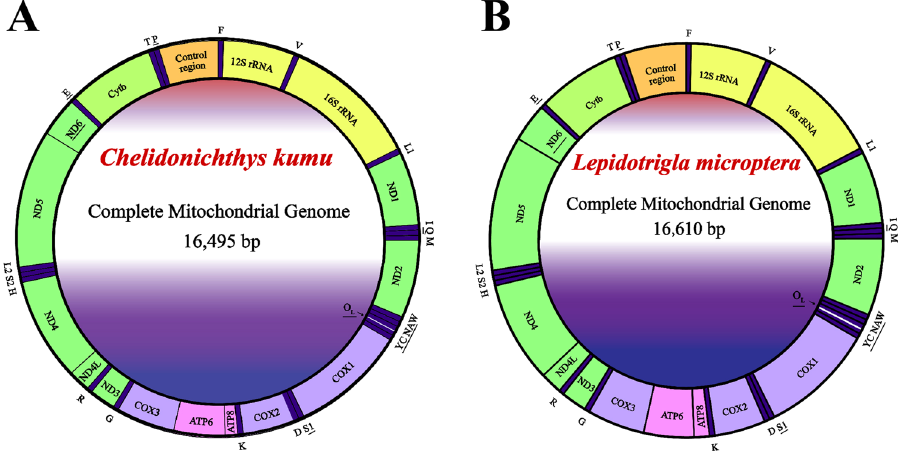
Figure 1. Circular map of the mitogenome of C. kumu ( A ) and L. microptera ( B ). Transfer RNAs are designated by the IUPAC-IUB single letter amino acid codes (L1: trnL CUN ; L2: trnL UUR ; S1: trnL AGN ; S2: trnL UCN ) Genome organization names not underlined indicate coding sequence on the heavy strand and those with underline indicate coding sequence on the light